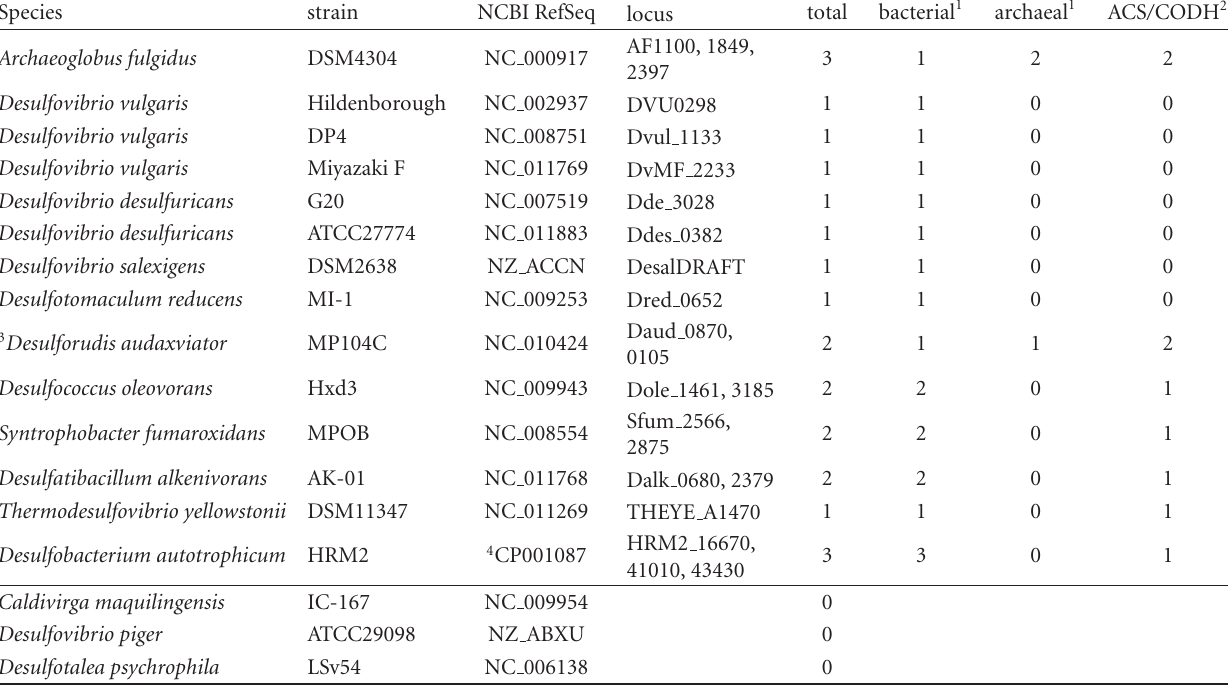
Table 2: CO-dehydrogenase genes in completed genome sequences of sulphate